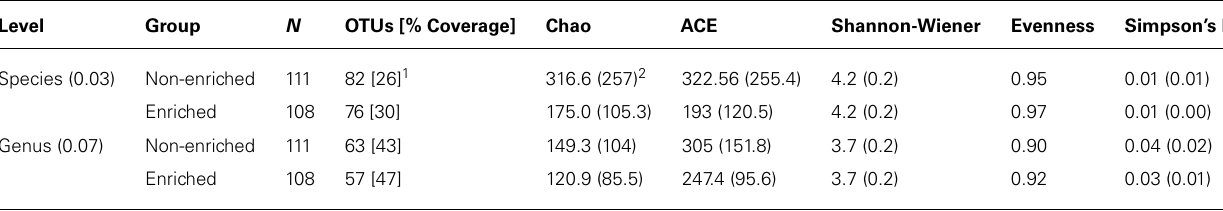
Table 1 | Calculated alpha diversity indices for lignocellulose-responsive and non-responsive bacterial communities at the 3 and 7% evolutionary distance level.